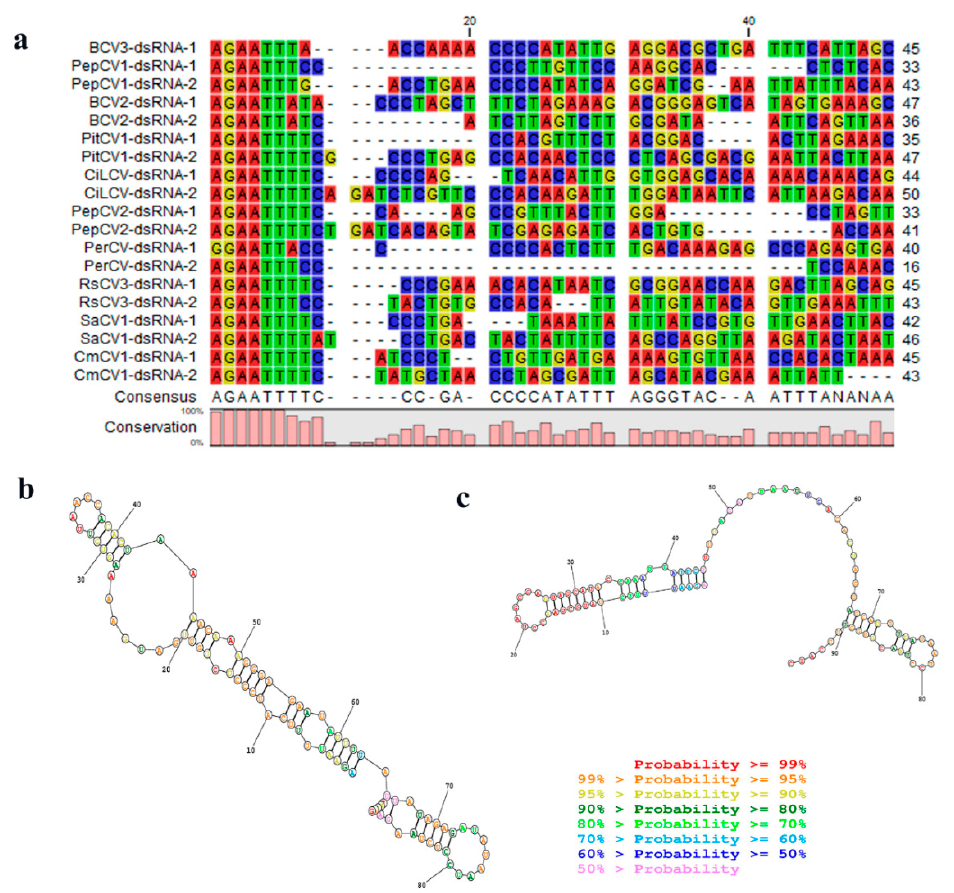
Figure 3. Terminal characteristics of the CmCV dsRNA-1 and dsRNA-2. ( a ) The conserved nucleotide stretches are present at the 5´-termini of CmCV dsRNA-1 and dsRNA-2. The secondary structure formed by the 5´-untranslated regions (5´UTR) of CmCV dsRNA-1 ( b ) and dsRNA-2 ( c ).